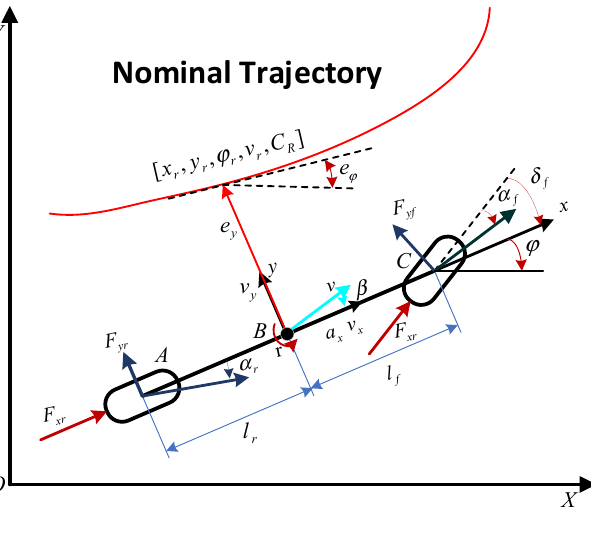
Figure 2. Trajectory tracking model schematic.